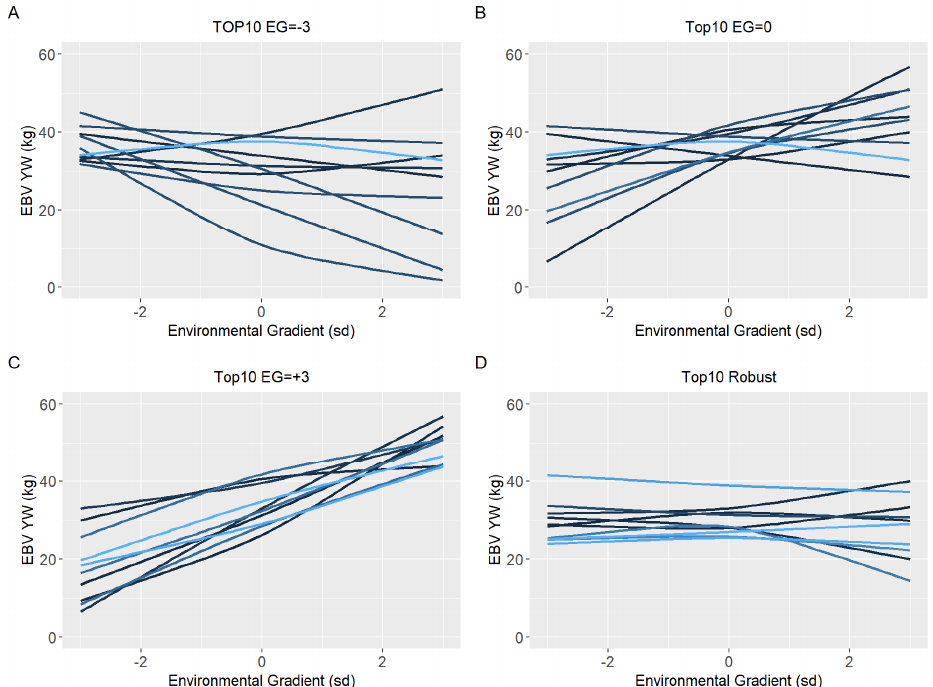
Figure 5. Estimated breeding values (EBV) reaction norms for yearling weight (YW) of Nellore cattle sires classified as top 10 for low ( A ), medium ( B ), and high environmental gradient ( C ), and top 10 robust ( D ), considering the reaction norm models (RNM) fitted with spline linear–linear heteroscedastic (RNM_l-l).